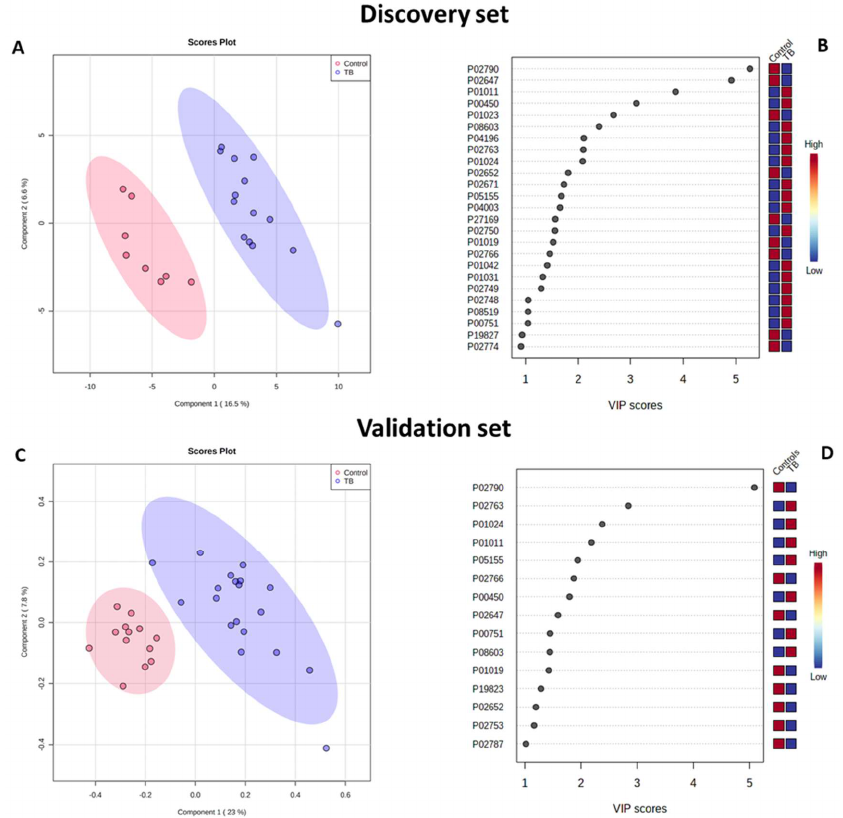
Figure 3. Serum proteomics PLS-DA model discriminates between controls and TB patients in the ( A , B ) discovery and ( C , D ) validation sets. ( A , C ) PLS-DA scores plot for the first and sec- ond components constructed with controls and TB patients serum proteins (for the discovery set: Q 2 = 0.841, permutations (2000) p = 0.018, n(control) = 8 and n(TB) = 14; for the validation set: Q 2 = 0.754, permutations (2000) p = 0.005, n(control) = 13 and n(TB = 18). Areas in red and blue represent the 95% confidence region. Dots represent the replicates for each condition. ( B , D ) Proteins responsible for the discrimination in the first component (VIP >